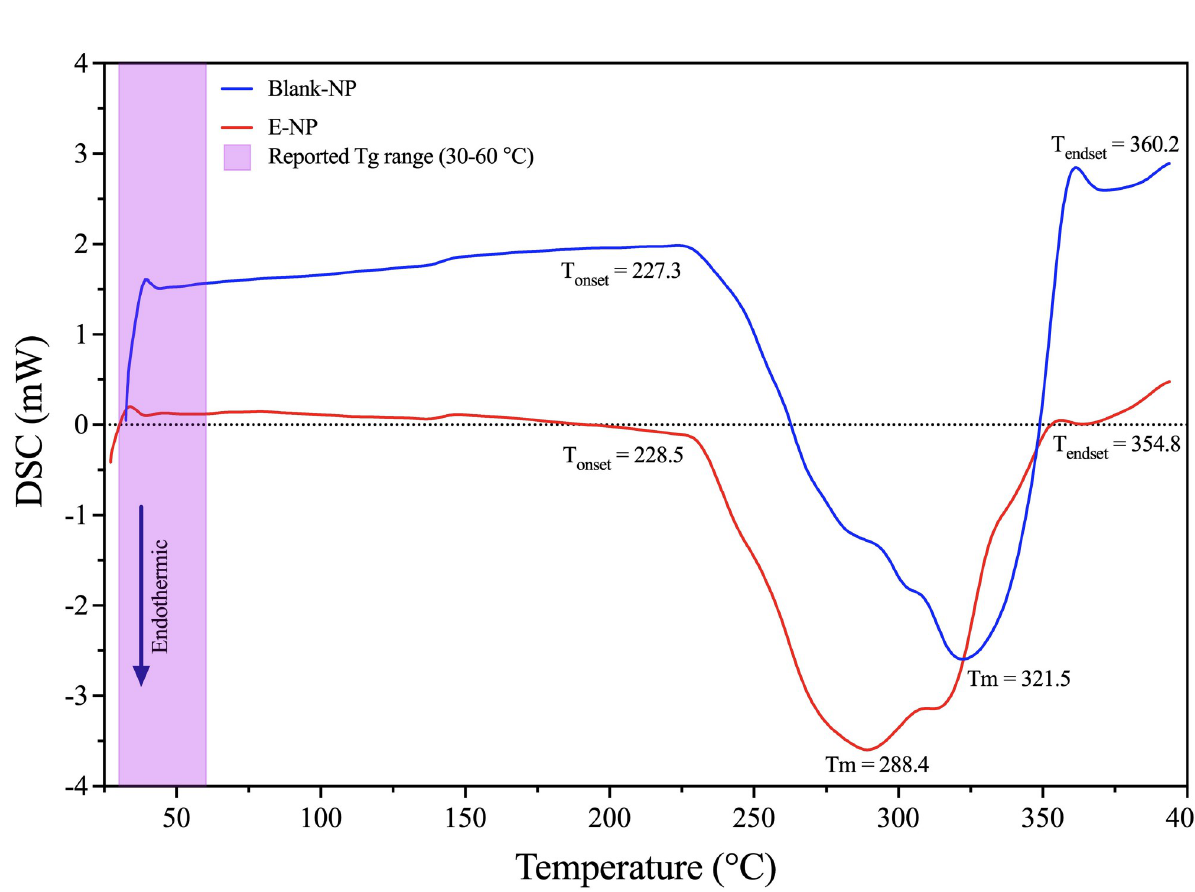
Fig 4. DSC analysis of PLGA NPs: Blank NP (blue line) and E-NPs (red line).